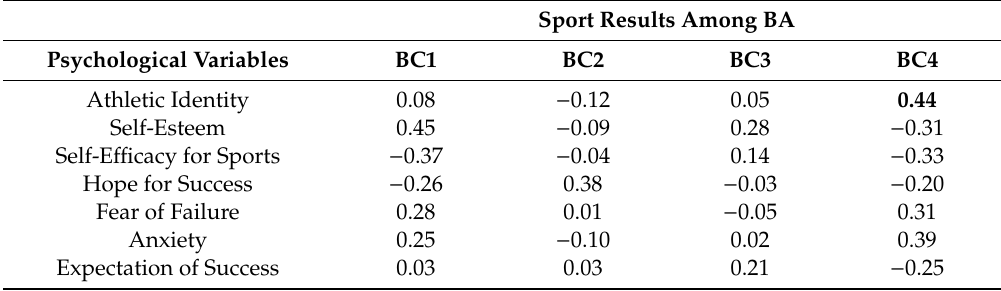
Table 3. Relationship between psychological variables and sport results among boccia athletes (BA) by sport classes (BC1, BC2, BC3, and BC4), expressed by correlation coe ffi cient. Sport Results Among BA